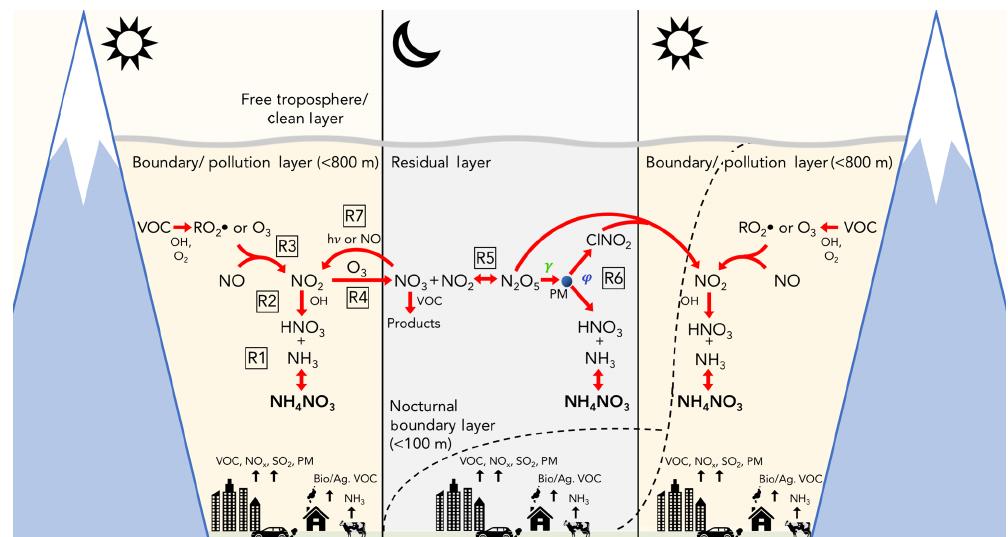
Figure 2. Illustration of the day–night dynamics and chemical cycles of reactive nitrogen oxides, O 3 , and NH 4 NO 3 during PCAP conditions in the SLV. The development of the nocturnal boundary layer and morning growth and mix-out are illustrated by the dashed lines. Figure is not to scale. Reaction (R6) represents the reaction N 2 O 5